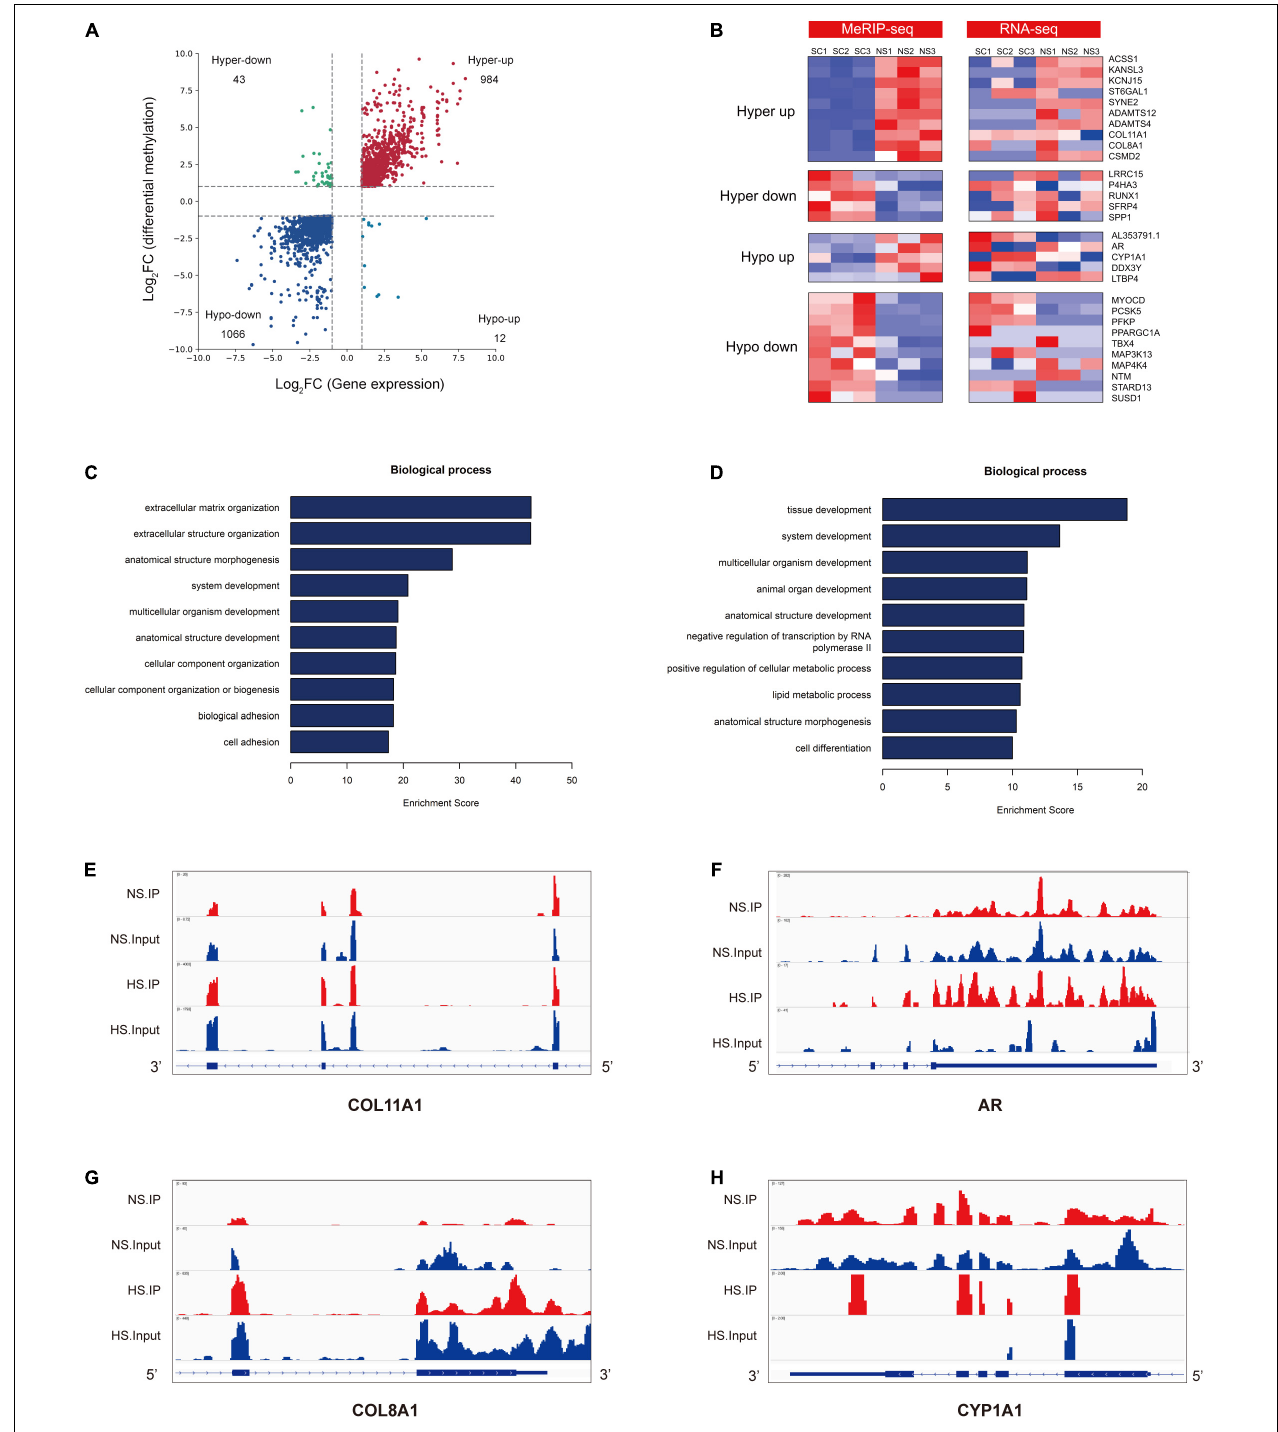
FIGURE 4 | Conjoint analysis of m 6 A-RIP-seq and RNA-seq data. (A) Distribution of genes with a significant change in both m 6 A and mRNA levels in hypertrophic scar (HS) samples compared with normal skin (NS) tissues (fold change > 2, p < 0.05). (B) Heat map of “hyper-up,” “hyper-down,” “hypo-up,” and “hypo-down” genes represented in panel (A) . (C) The top 10 gene ontology (GO) terms of the biological process for the “hyper-up” genes in HS compared with NS. (D) The top 10 GO terms of the biological process for the “hypo-down” genes in HS compared with NS. (E–H) Data visualization of the top four differently expressed genes containing differently methylated peaks in Table 5 . (E) Data visualization of COL11A1 mRNA m 6 A modification in HS compared with NS. (F) Data visualization of AR mRNA m 6 A modification in HS compared with NS. (G) Data visualization of COL8A1 mRNA m 6 A modification in HS compared with NS. (H) Data visualization of CYP1A1 mRNA m 6 A modification in HS compared with